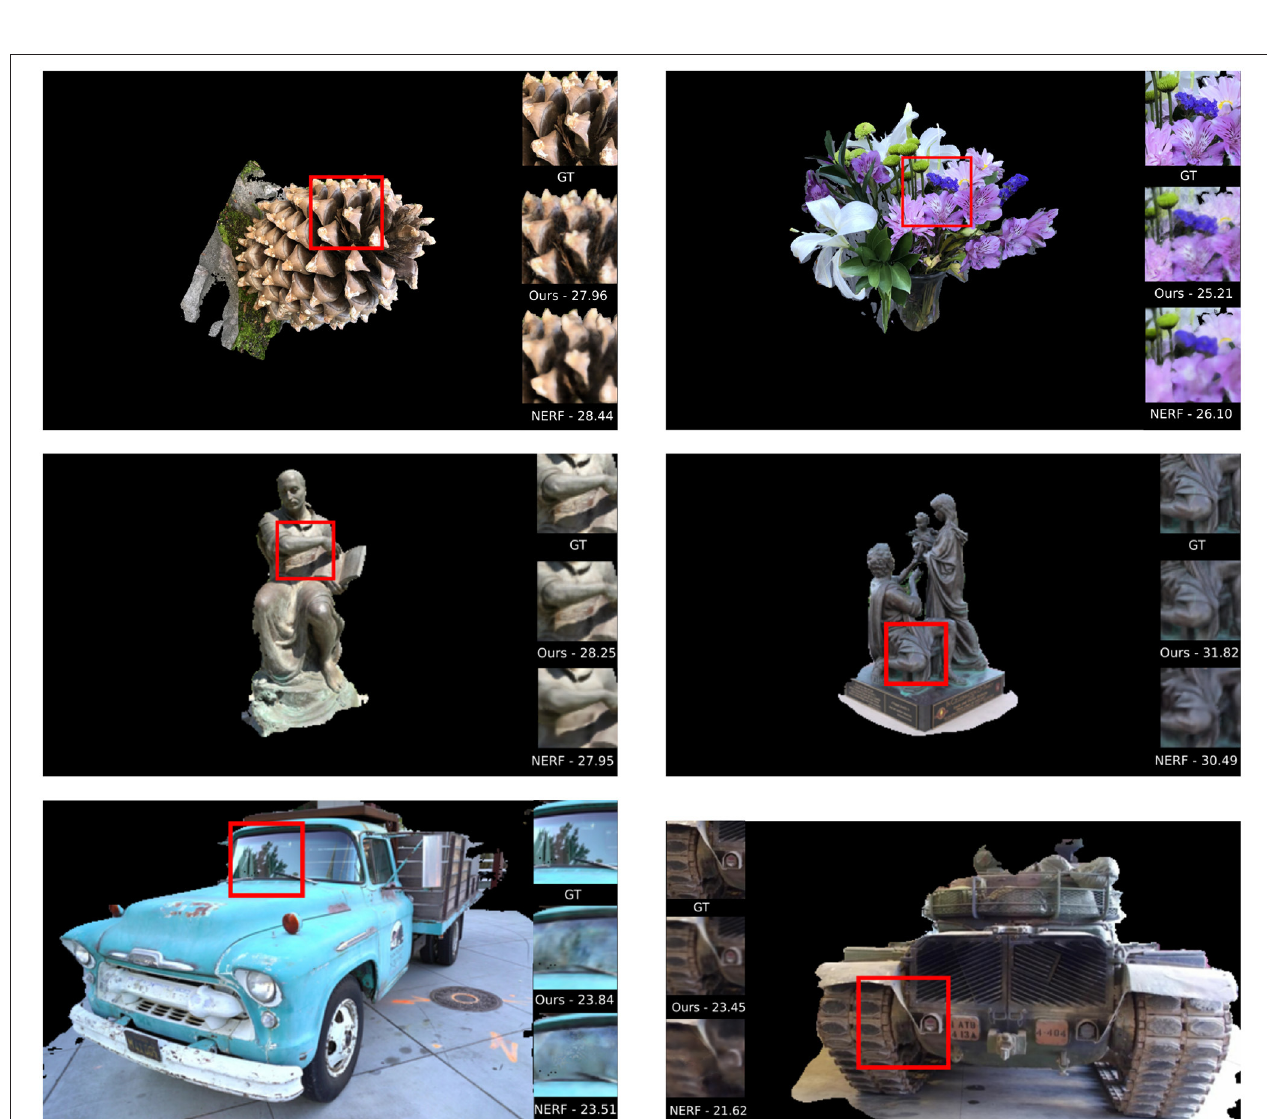
FIGURE 6 | Results on the 360 ◦ scenes from the NERF data set as well as scenes from the Tanks and Temples data set. The cut-outs show the ground truth, our reconstruction and NERF without view-dependence. Corresponding average PSNR-scores computed over a set of hold out views are shown beneath each cut-out.